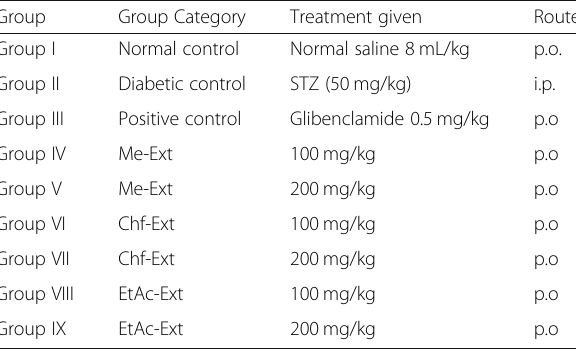
Table 1 Experimental design and various tretament groups used in the